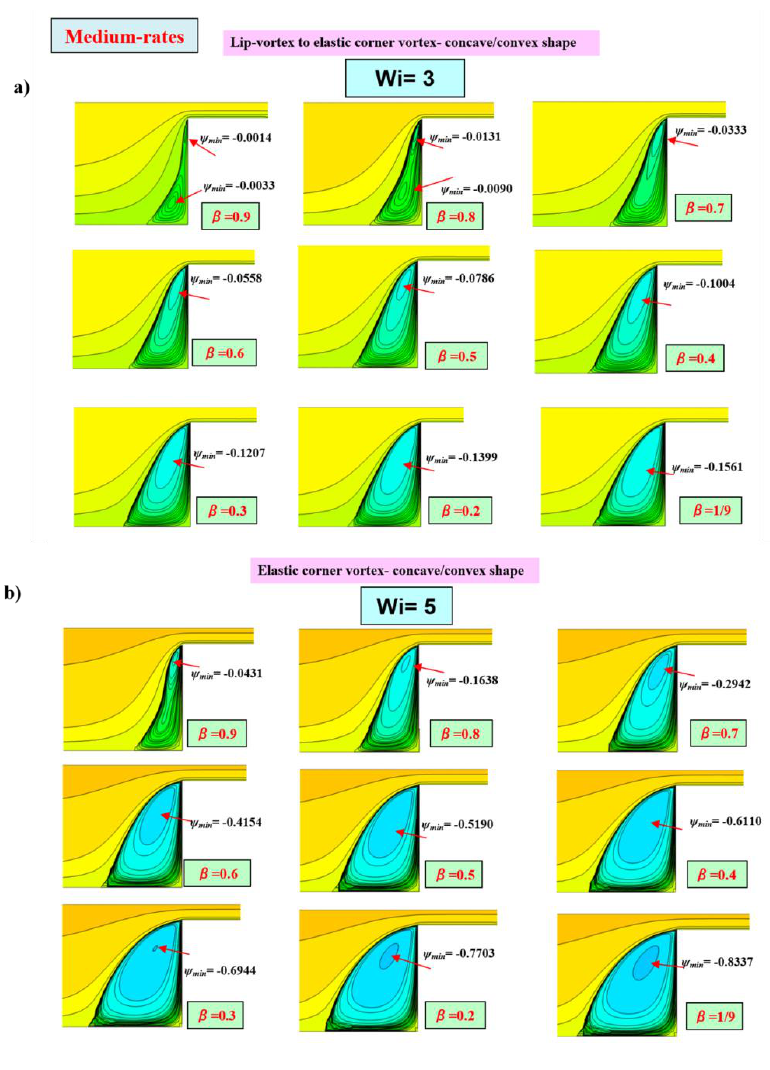
λ = 0.075]; D  = 0.075]; D